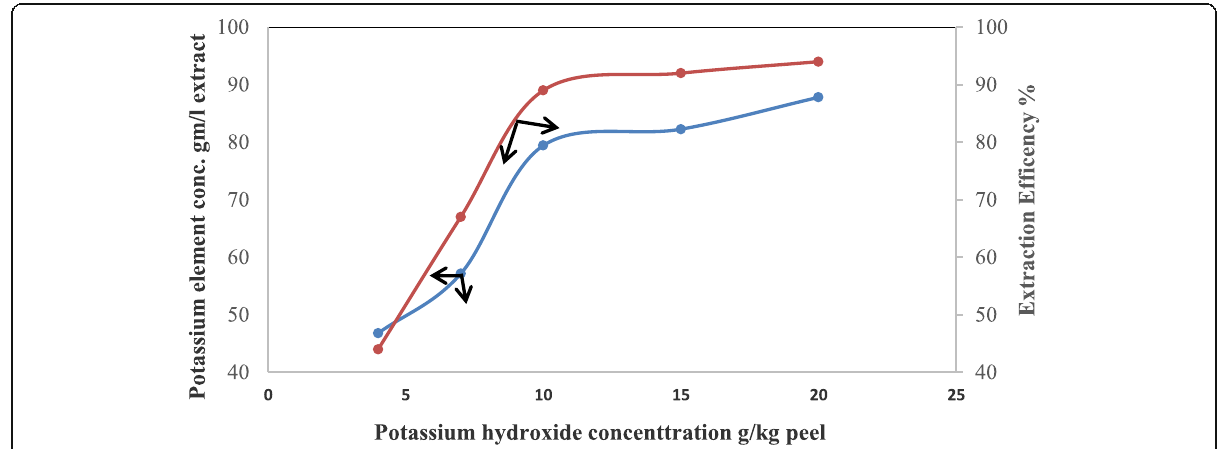
Fig. 4 Effect of potassium hydroxide concentration on potassium element extraction from banana